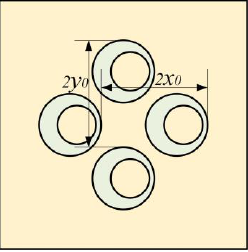
Figure 8. Definitions for the configuration of the MAM loaded with four asymmetric masses.